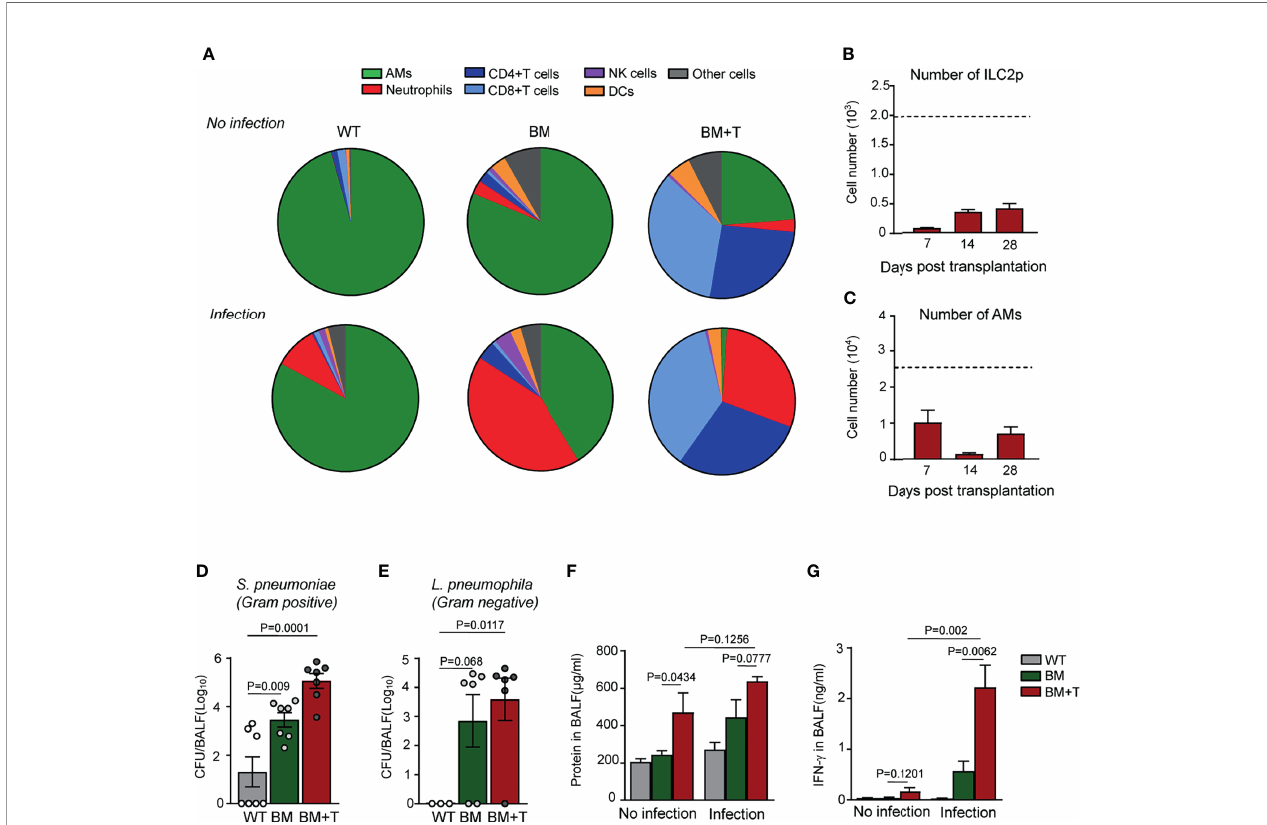
FIGURE 5 | AM reconstitution and anti-infection immunity in mice with GVHD. (A) Ten days after BMT, allogeneic recipient mice were infected with 2 × 10 5 Streptococcus pneumoniae via i.n. 48 h after infection, immune cells in BAL fl uid were analyzed, and percentages of these cells were shown. Cells in mice without infection were also analyzed by fl ow cytometry. (B) ILC2 precursors (Lin − a 4 b 7 + CD25 + ) were analyzed in bone marrow of allogeneic recipient mice received both BM grafts and splenic T cells. Dotted line indicates the level of ILC2p cells in WT mice. Data are represented as mean ± SEM (n = 3). (C) The number of BAL AMs was analyzed at different time points of GVHD mice after BMT. Dotted line indicates the level of BAL AMs in WT mice. Data shown are the pooled results of two independent experiments with three mice per group in each experiment. (D) CFUs of bacteria in BAL fl uid were analyzed 48 h after S. pneumoniae infection. Data are represented as mean ± SEM. (E) Ten days after BMT, allogeneic recipient mice were infected with 5 × 10 6 Legionella pneumophila via i.n. 48 h after infection; CFUs of bacteria in BAL fl uid were analyzed. WT mice infected with the same amount of bacteria were used as control. (F) Total protein concentrations and (G) IFN- g in BAL fl uid were analyzed. WT mice infected with the same amount of bacteria were used as control. Data shown are the pooled results of two independent experiments with three to four mice per group in each experiment. Data are represented as mean ± SEM. AM, alveolar macrophage; GVHD, graft versus host disease; BMT, bone marrow transplantation; BAL, bronchoalveolar lavage; ILC2, group 2 innate lymphoid cell; WT, wild